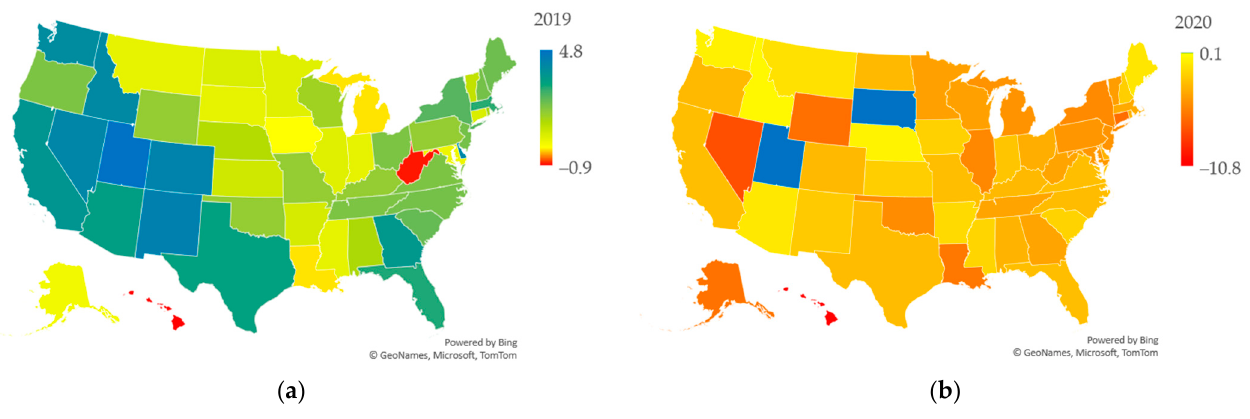
Figure 7. Percent change in state GDP in: ( a ) 2019; ( b ) 2020 [31].